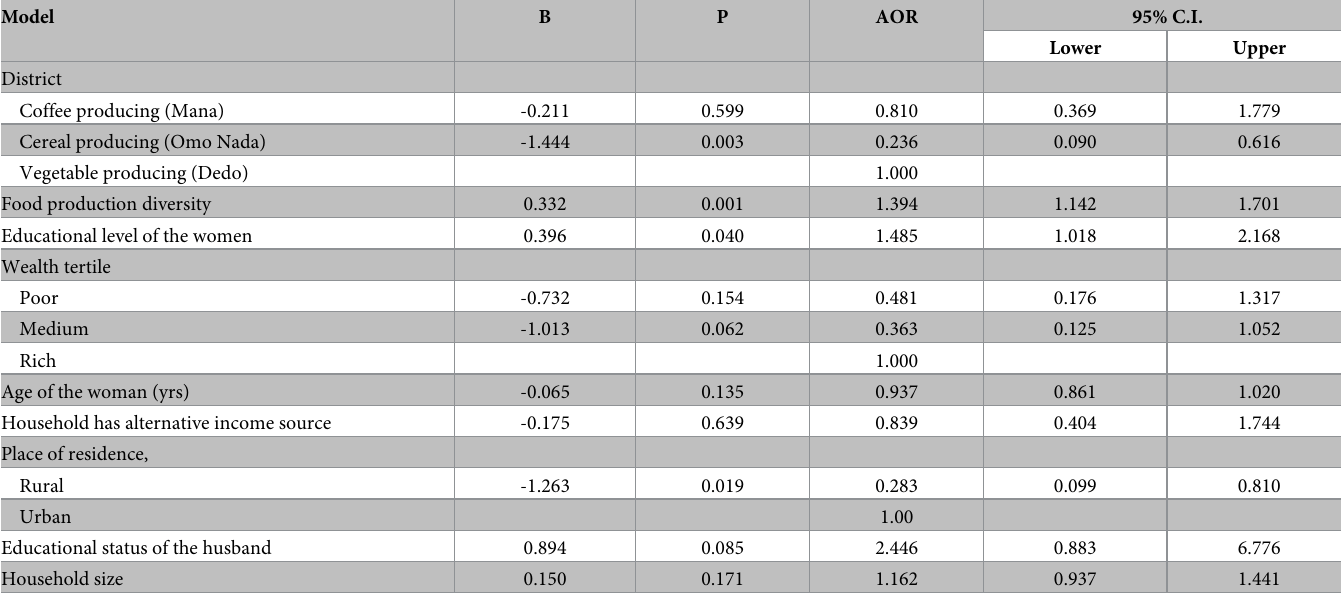
Table 5. Multivariable logistic regression model predicting the likelihood of having MDD-W in Jimma Zone, Southwest Ethiopia. Model